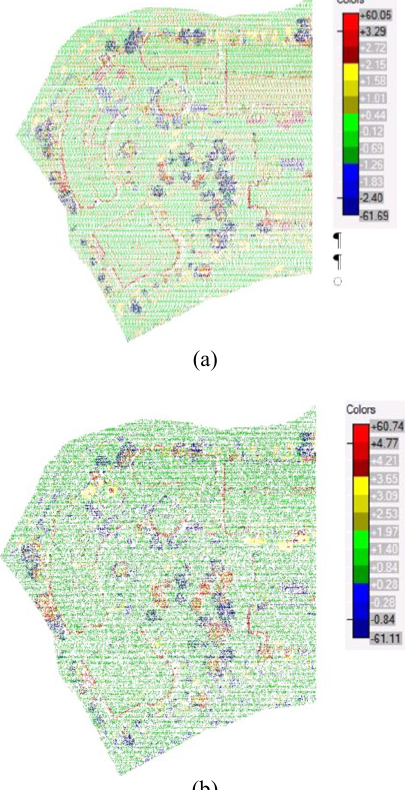
Figure 4 for DLR DSM (a) and UltraMap DSM (b) in urban area.